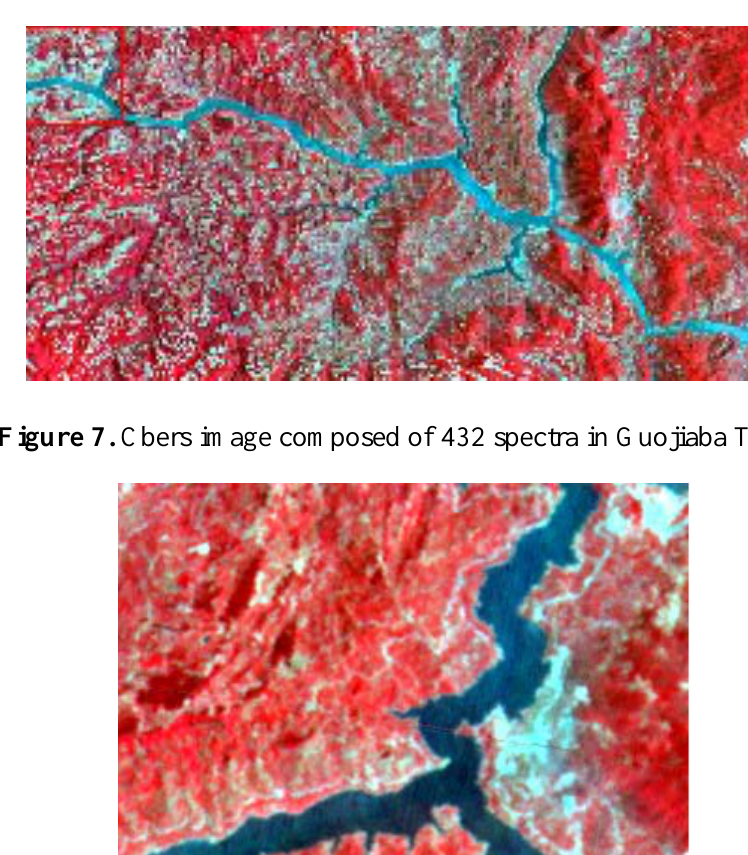
Figure 6. Cbers image composed of 432 spectra in Three Gorges.